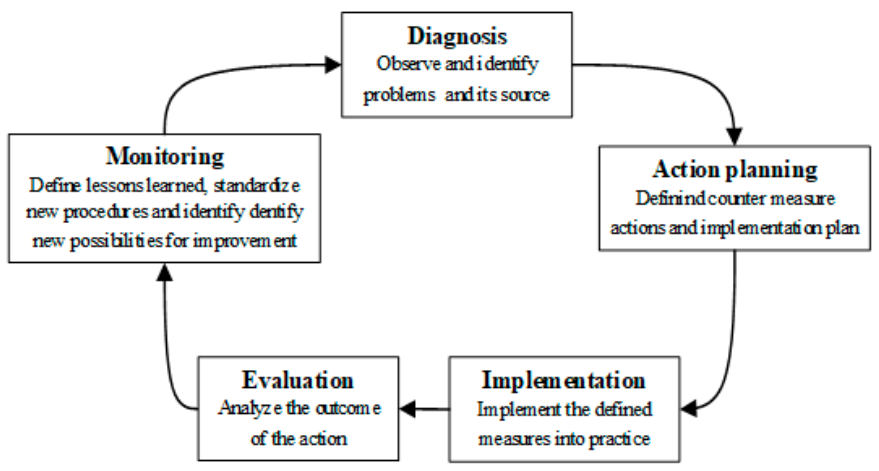
Figure 1. Different steps of the action–research cycle used in this work. In the specific context of this work, the different phases previously described and depicted in Figure 1 can be translated into concrete actions, as described in Table 1. Table 1. Specific content of each step of the action–research methodology in this work.